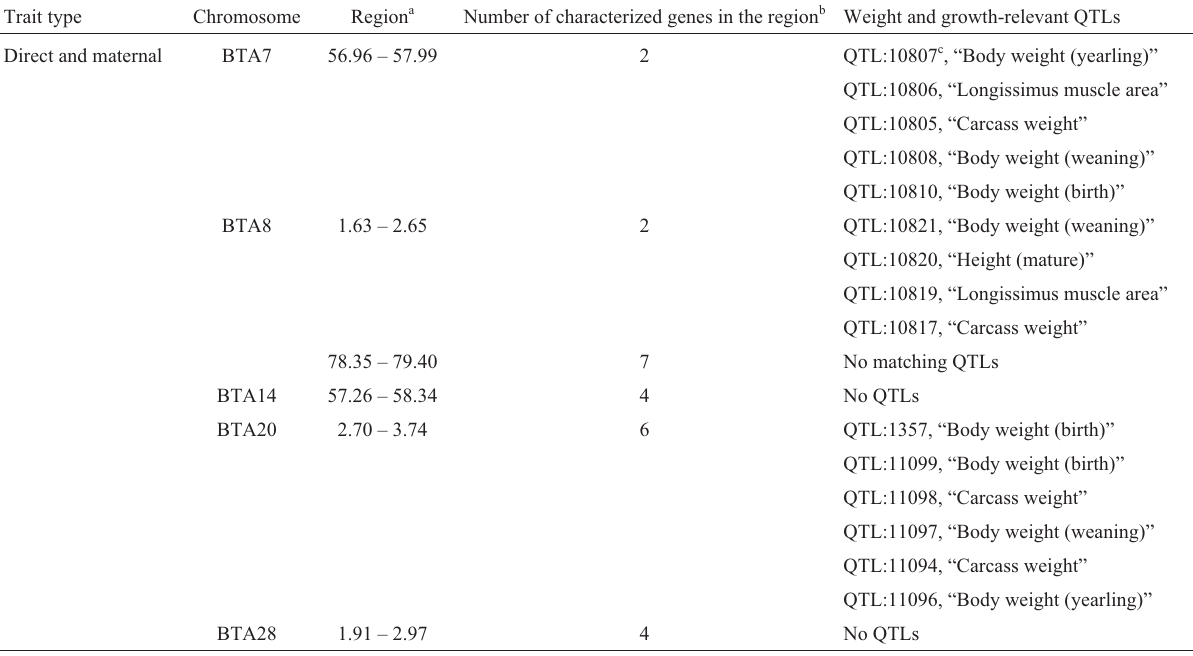
Table 3 - Most important regions of DNA related to weaning weight in Zebu Brahman breed. Trait